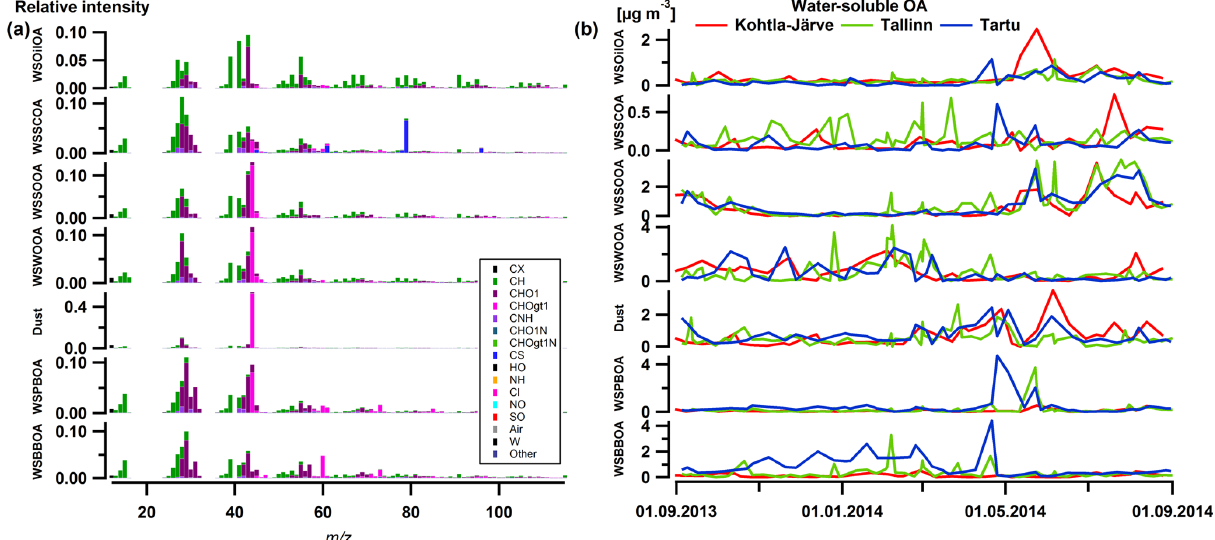
Figure 1. Factor profiles (a) and time series (b) of the seven-factor solution: industrial or oil combustion OA (OilOA), sulfur-containing OA (SCOA), summer oxygenated OA (SOOA), winter oxygenated OA (WOOA), dust-related OA (Dust), primary biological OA (PBOA) and biomass burning OA (BBOA). Note that the water-soluble parts are illustrated here.